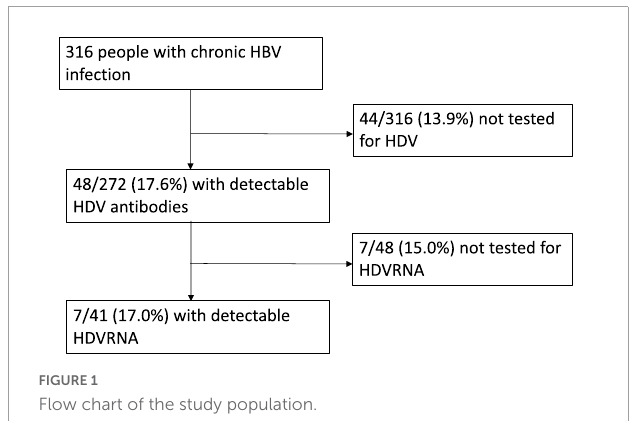
FIGURE1 Flow chart of the study population.